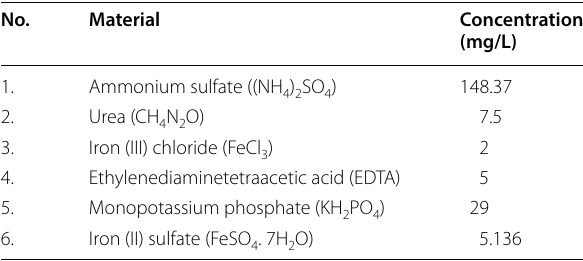
Table 2 Composition of modified Walne’s medium II